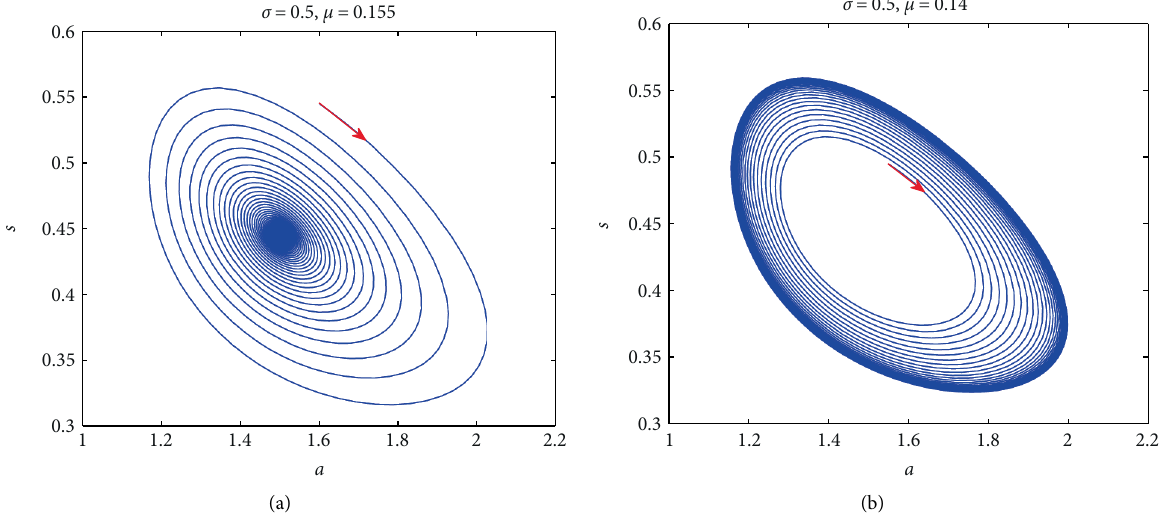
∗ ∗ ( 𝑎 , 𝑠 ) = (1.500, 0.4444) coverages to stable limit cycle